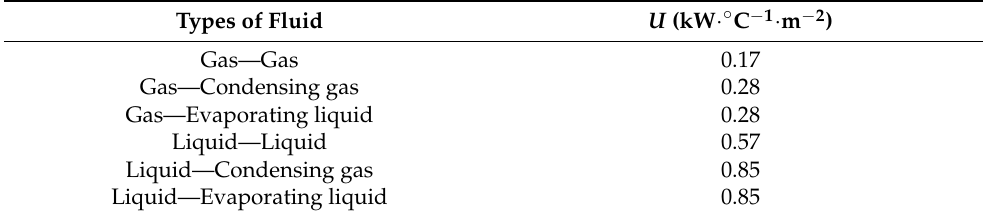
Table 1. Heat transfer coefficients for different